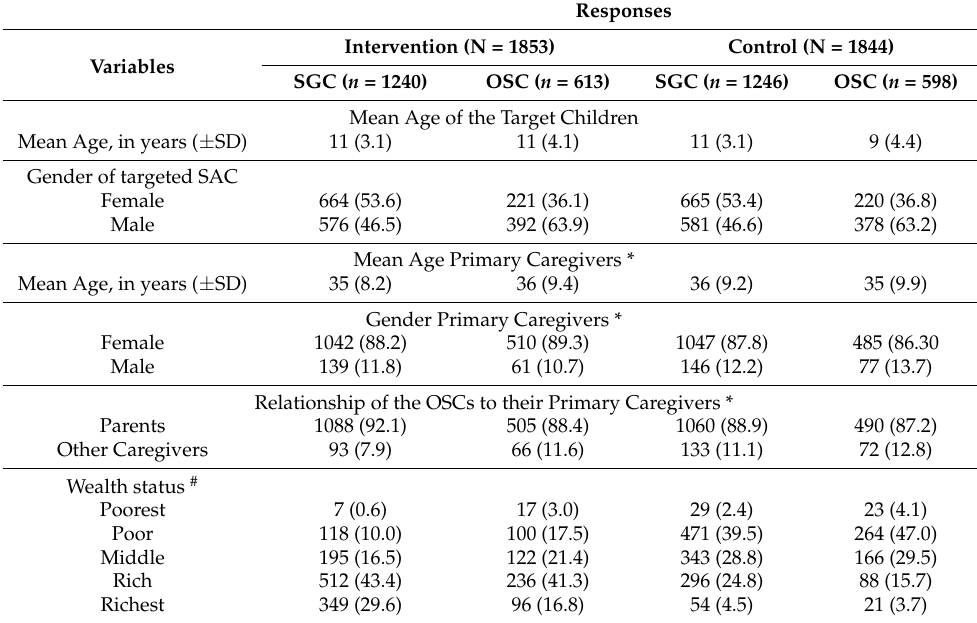
Table 2. Demographic information and self-reported deworming coverage of